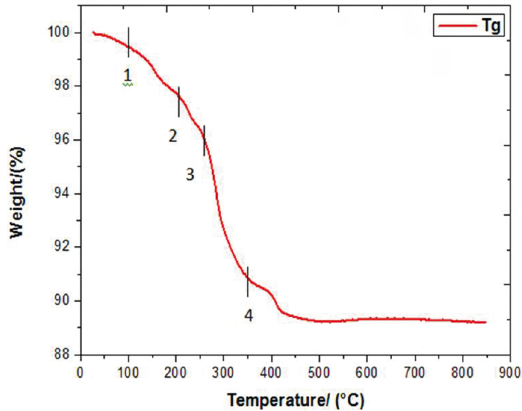
Figure 2. APT thermogravimetric analysis Curve